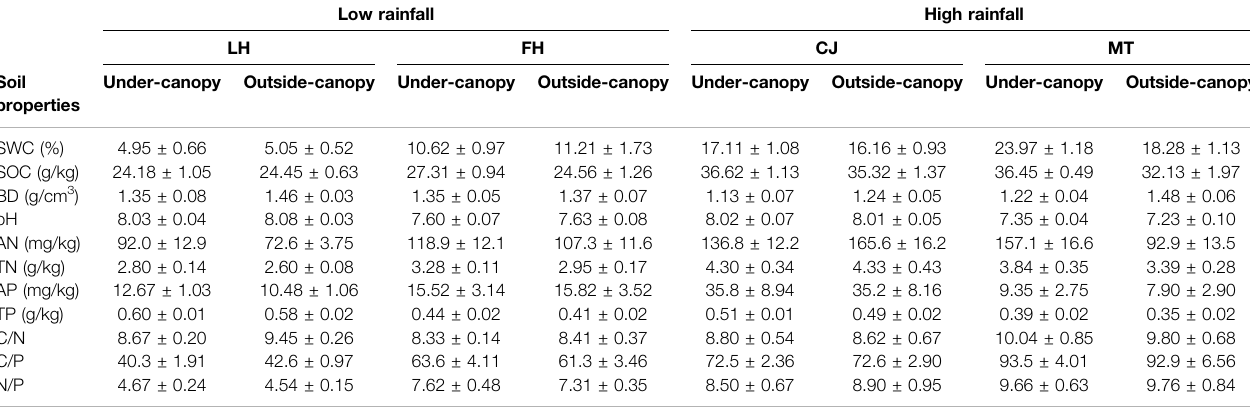
The data were analyzed using the general linear mixed model, and the results are shown in Table 2 . SWC, soil water content; SOC, soil organic carbon; BD, bulk density; AN, available nitrogen; TN, total nitrogen; AP, available phosphorus; TP, total phosphorus; C/N, SOC:TN ratio; C/P, SOC:TP ratio; N/P, TN:TP ratio; GP, Gram-positive bacteria; GN, Gram-negative bacteria; B, total bacteria; F, saprophytic fungi; AMF, arbuscular mycorrhizal fungi; tPLFA, total PLFA; BG, β -1,4-glucosidase; NAG, β -1,4-N-acetylglucosaminidase; LAP, leucine aminopeptidase; AlkP, alkaline phosphatase.